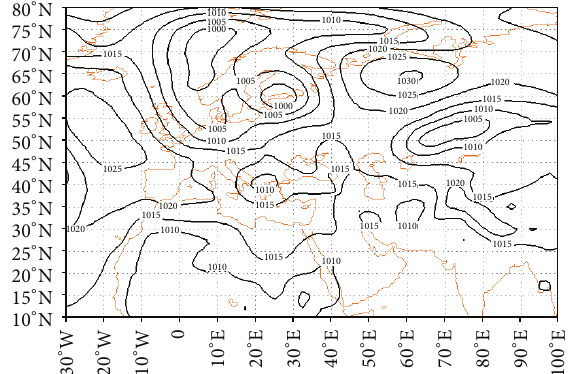
Figure 17: Sea level pressure map.